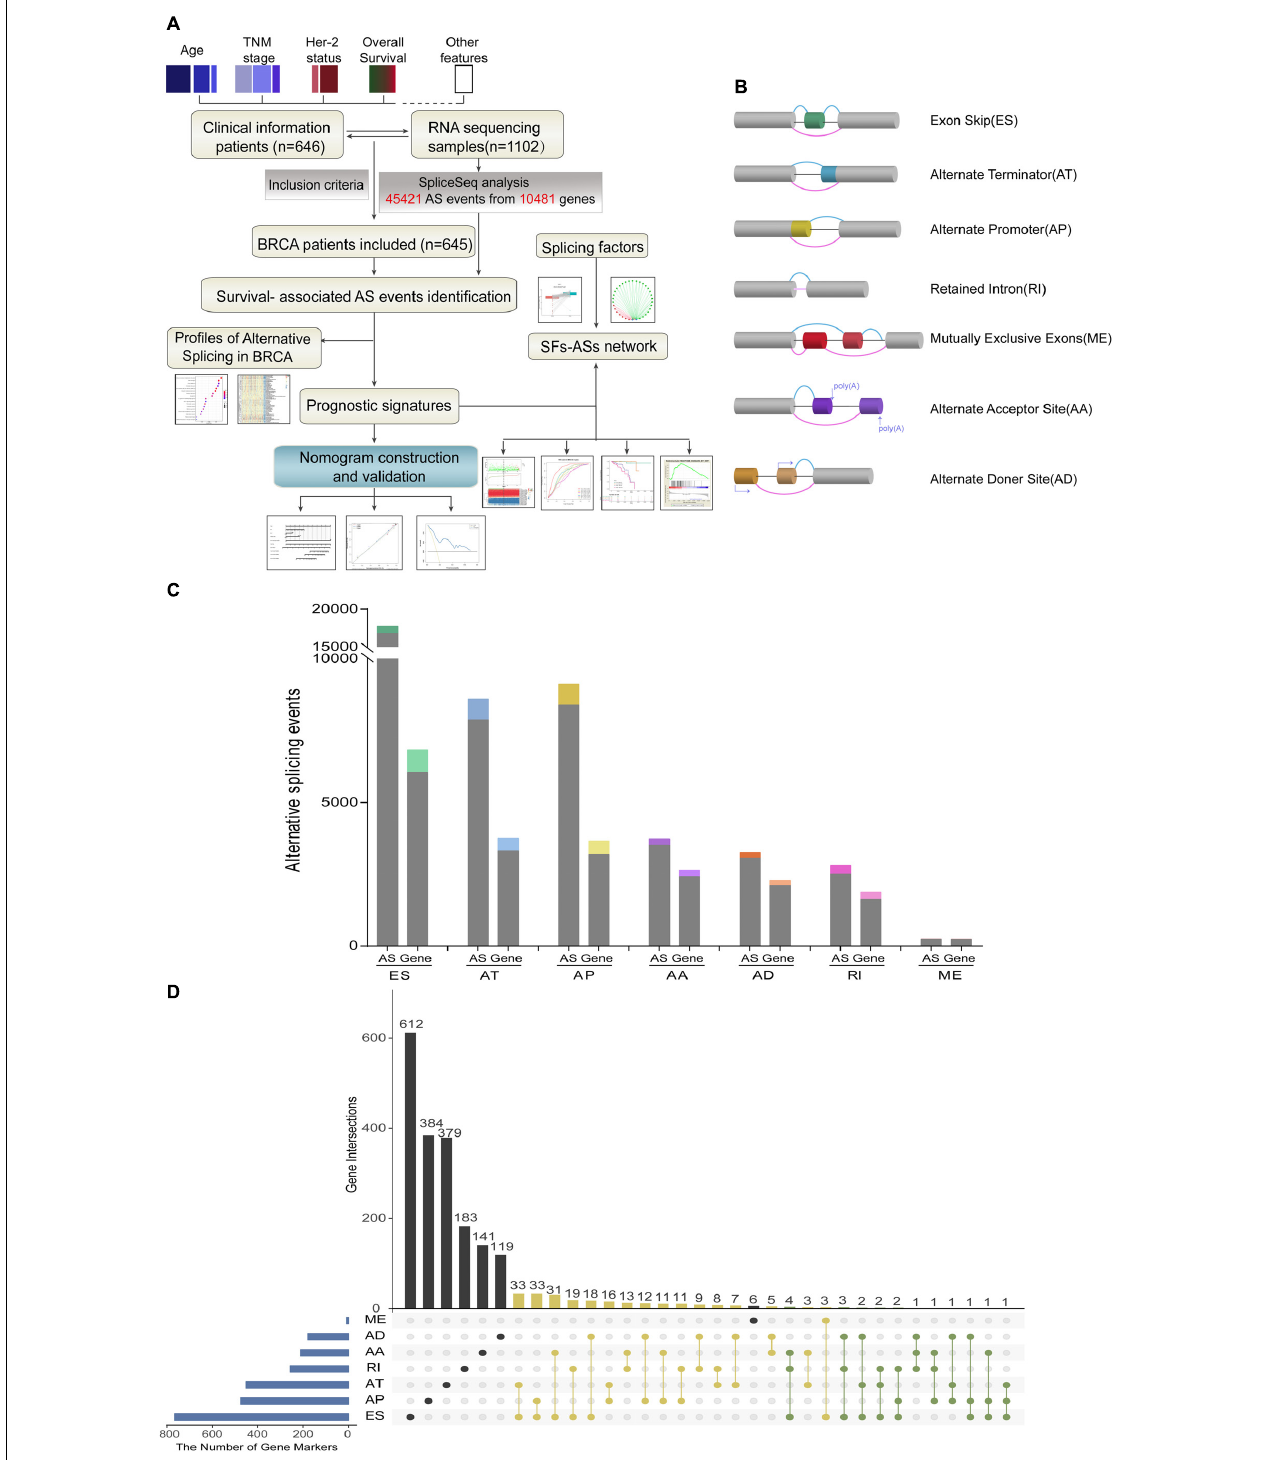
FIGURE 1 | Overview of AS events profiling in BRCA cohort. (A) Flowchart for profiling AS of BRCA. (B) Illustration for splicing pattern of seven types of AS events, including Exon Skip (ES), Alternate Promoter (AP), Alternate Terminator (AT), Alternate Donor site (AD), Alternate Acceptor site (AA), Mutually Exclusive Exons (ME), and Retained Intron (RI). (C) Seven types of AS events and corresponding genes from the 645 BRCA patients were depicted according to classified P -value of 0.05. The gray bars represent the prognosis irrelevant AS events and involved genes. The color bars represent the prognostic AS events and parent genes filtered by univariate Cox analyses. (D) Upset plot of gene interactions between the seven types of prognosis-related AS events ( n = 3071). The yellow dot lines represent that one gene could have two types of prognostic AS events while blue dot lines represent the genes which occupied up to three types of survival-associated AS.